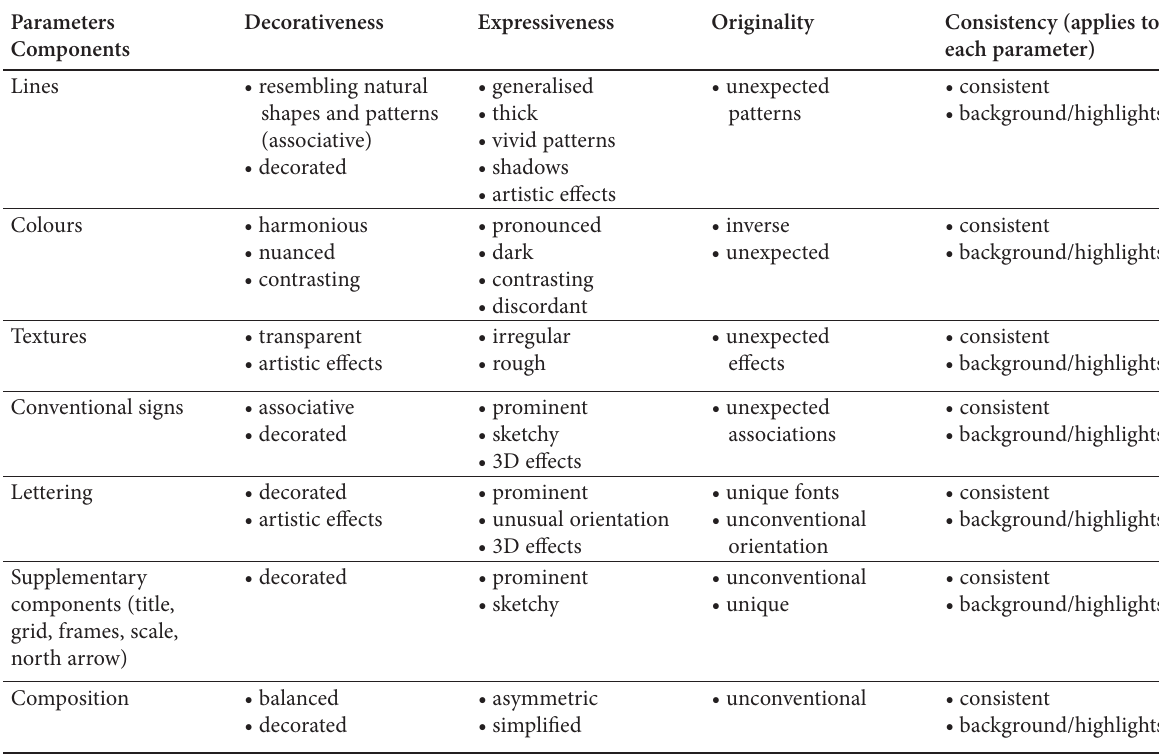
Table 1. Stylistic parameters and their indications Parameters